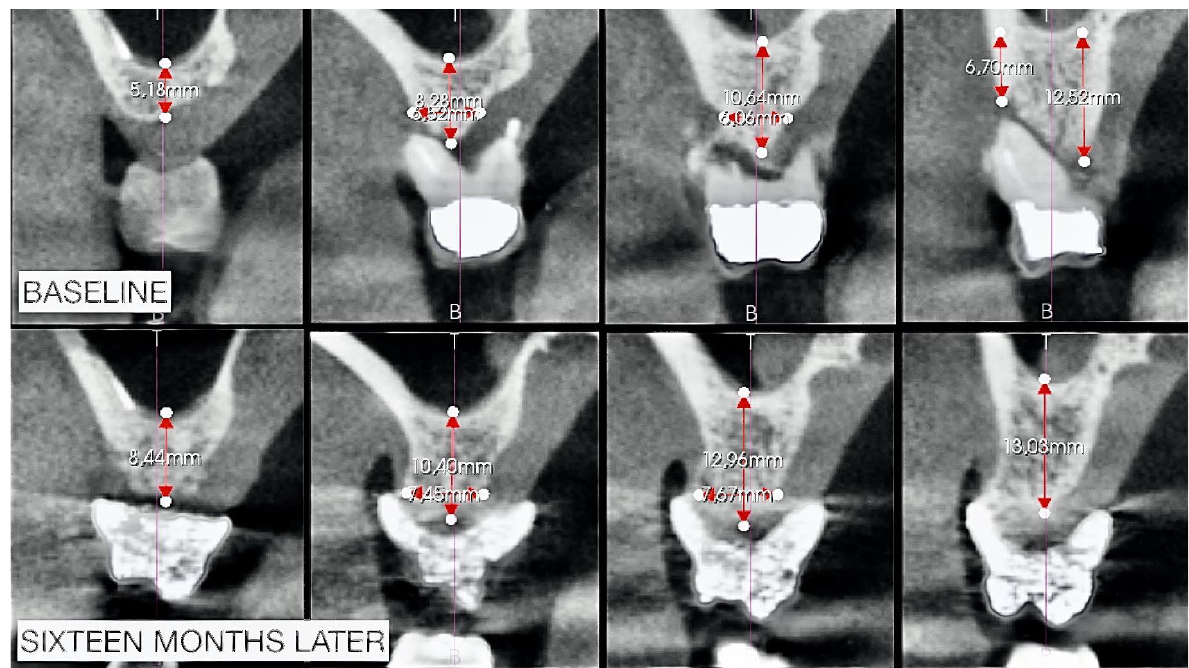
Figure 14. Measurements applied to the sections corresponding to teeth 1.7 and 1.6.